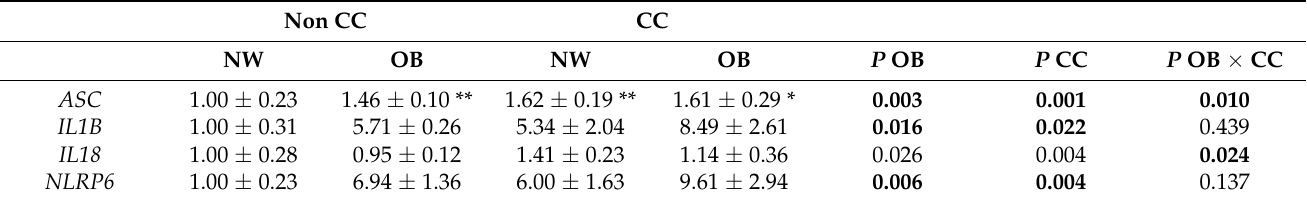
Table 3. Gene expression levels of inflammation-related factors in human visceral adipose tissue.